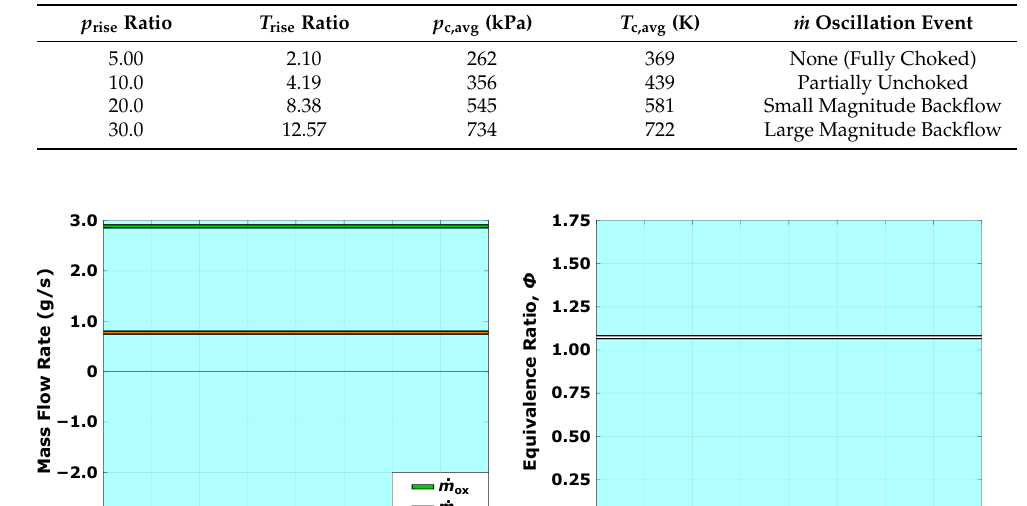
Table 3. Summary of the investigated test cases.